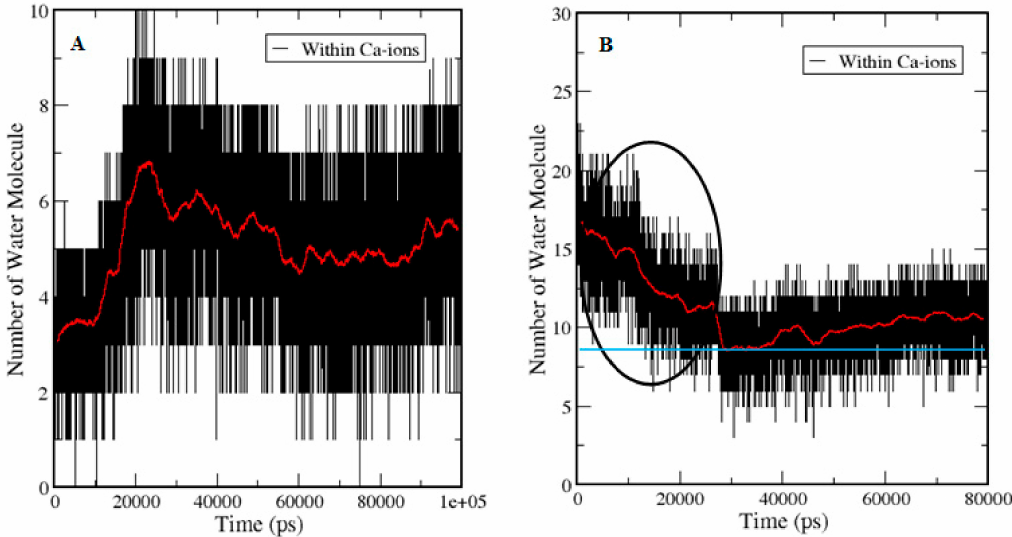
Figure 9. Hydration of Ca 2 + and execution of water dynamics. A represents the calculation of water molecules in the holo-S100A1 system during simulation and B denotes the system of free entry of Ca 2 + into the bulk. Red lines show the average number of water molecules around Ca 2 + ions. The blue line in frame B indicates the mean point of the lowest number of water molecules. At the beginning of simulation, elevation in the number of water molecules is shown in A, whereas, in fB, a drop in water molecules is noted, revealing that the Ca 2 + are approaching the surface of protein (black circle). However, after contacting the blue line, an elevation is noted similar to A, which suggests that a similar behavior occurred in holo